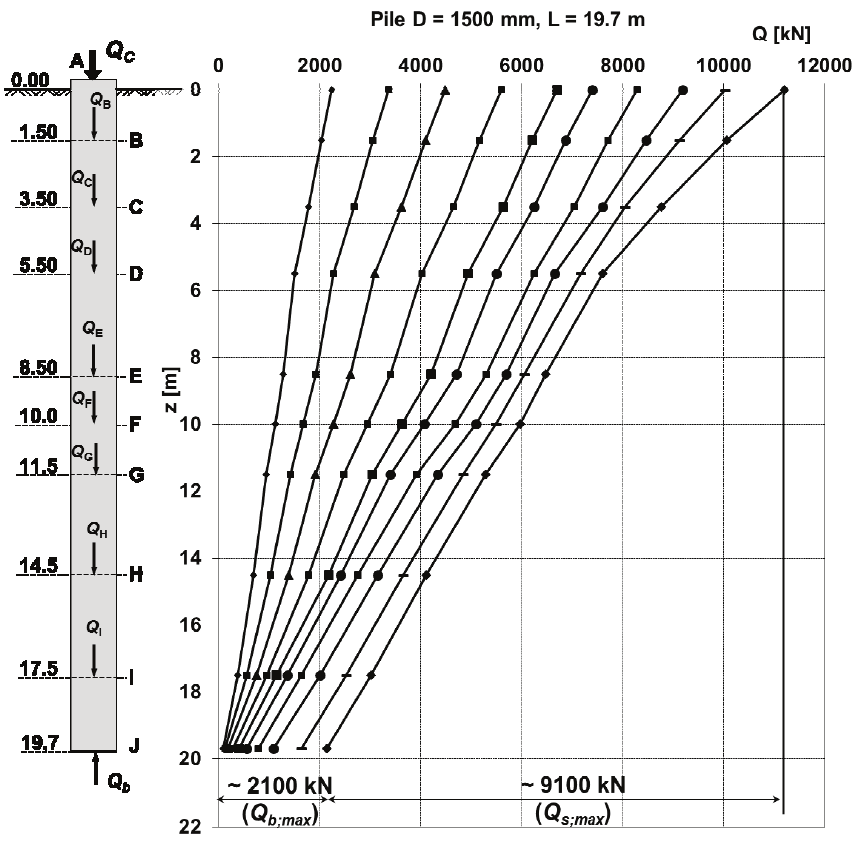
Fig. 7. Load distribution in a numerically modelled